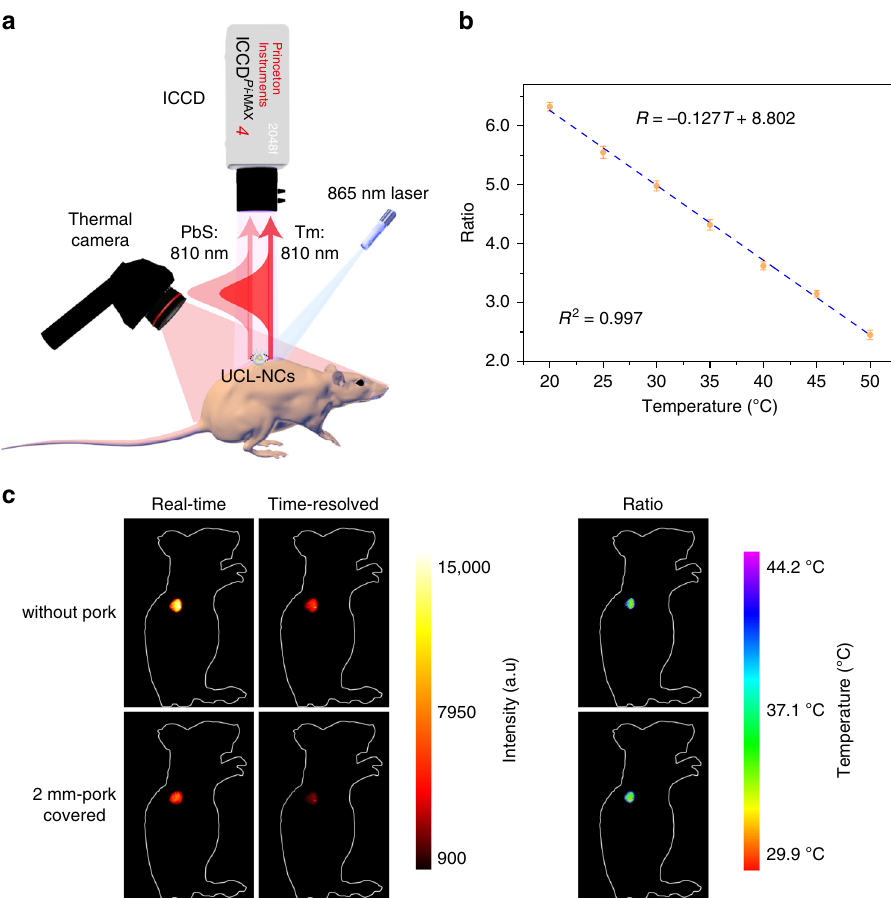
Fig. 5 Temperature monitoring in vivo using UCL-NCs. a Schematic diagram of sur fi cial and intratumoral monitoring in vivo. b The standard curve for temperature evaluation in vivo measured with the same wavelength ratiometric probe based on UCL-NCs with the excitation of 865nm laser using a home-built time-gated bioimaging system. c Real-time, time-gated and ratio UCL imaging without or with a 2 mm-pork tissue slice covering in vivo under irradiation by a 865 nm laser (0.5 W cm − 2 ) for 30 s. The ratio imaging fi gure was obtained using image arithmetic (Ratio = (Real time − Time gated)/ Time gated). Source data are provided as a Source Data fi